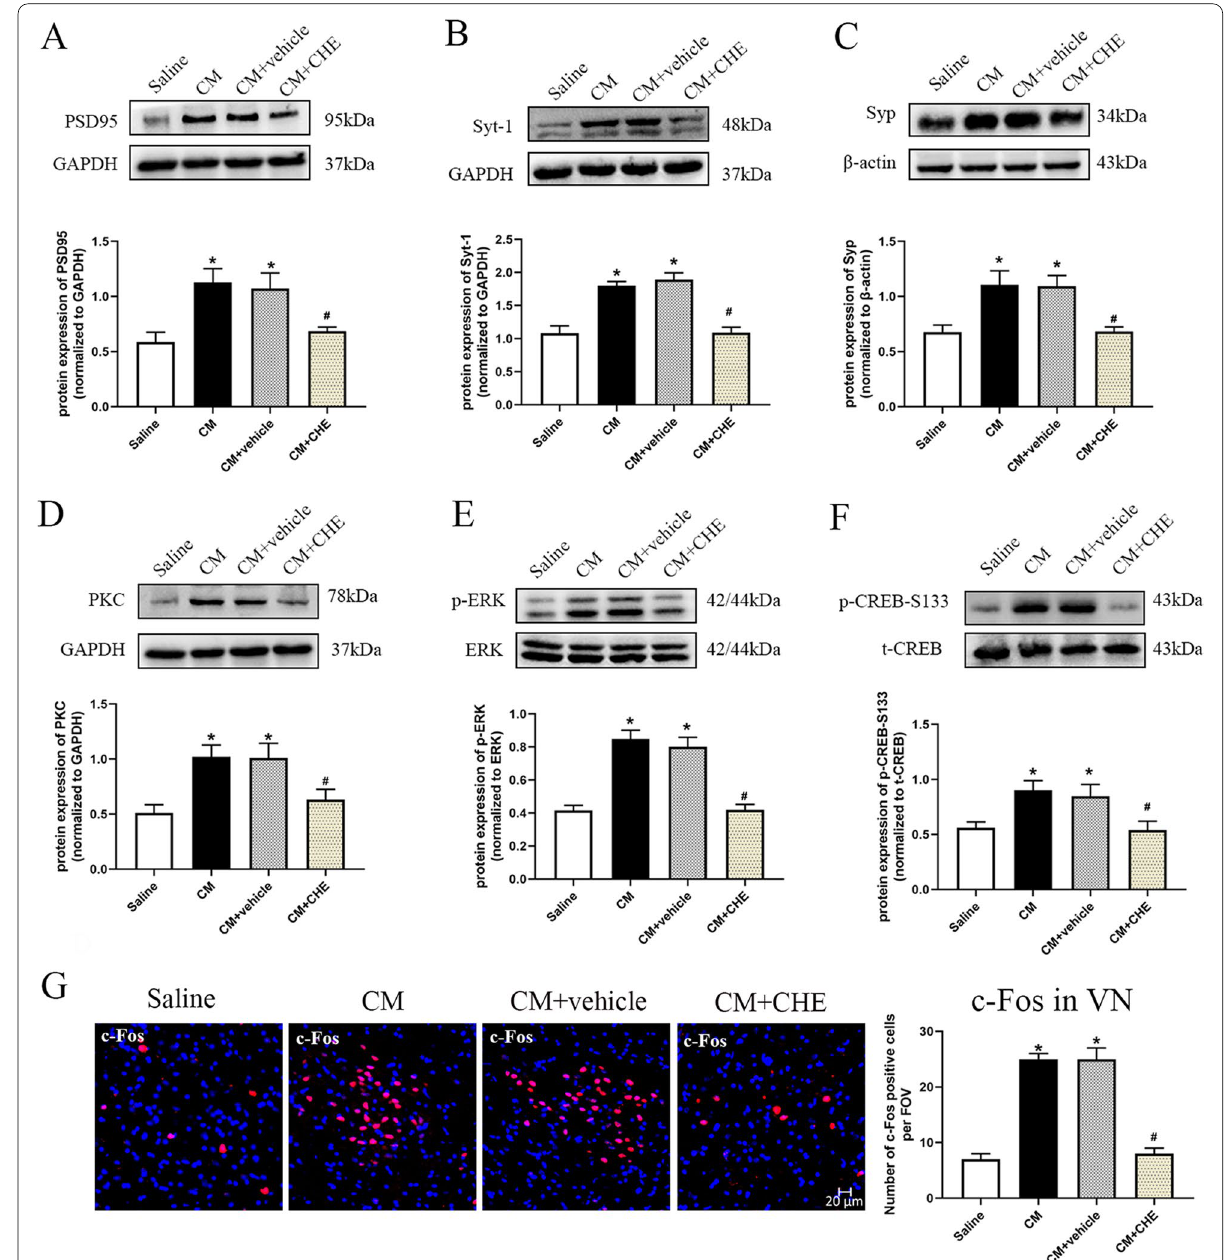
Fig. 6 Inhibition of PKC activity suppressed NTG-induced overexpression of synaptic associated proteins, reduced downstream phosphorylated ERK and CREB-S133 levels and inhibited neuronal activation after CM. Representative western blot bands and densitometric quantification of PSD-95 ( A ), Syt-1 ( B ), Syp ( C ), PKC ( D ), p-ERK ( E ) and p-CREB-133 ( F ) after CM. n of c-Fos staining in VN. The nuclei were stained with DAPI (blue). n Dunnett; * p < 0.05 compared with saline group, # p < 0.05 compared with CM